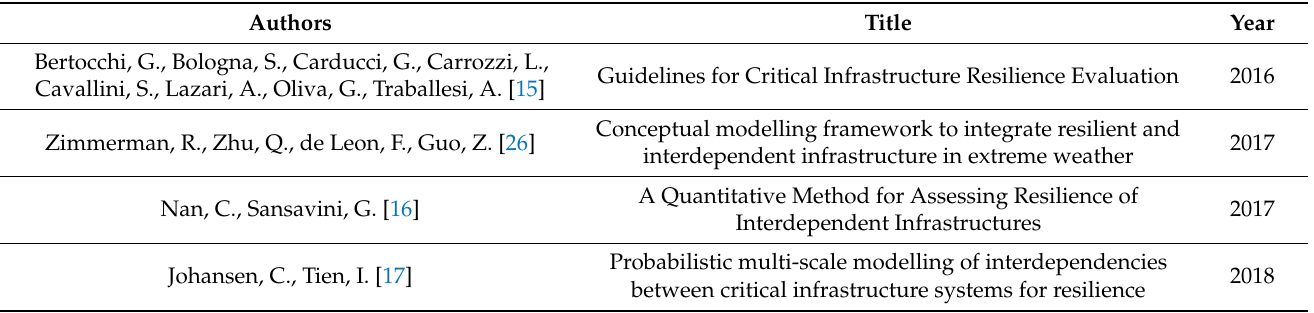
Table 2. An overview of the selected resilience assessment approaches in the energy sector.